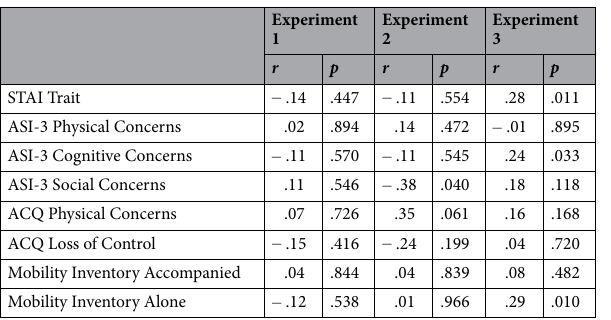
Table 2. Correlations between anxiety measures and thigmotaxis. STAI = State-Trait Anxiety Inventory; ASI-3 = Anxiety Sensitivity Index—3, ACQ = Acoraphobic Cognitions Questionnaire, MI = Mmobility Inventory.